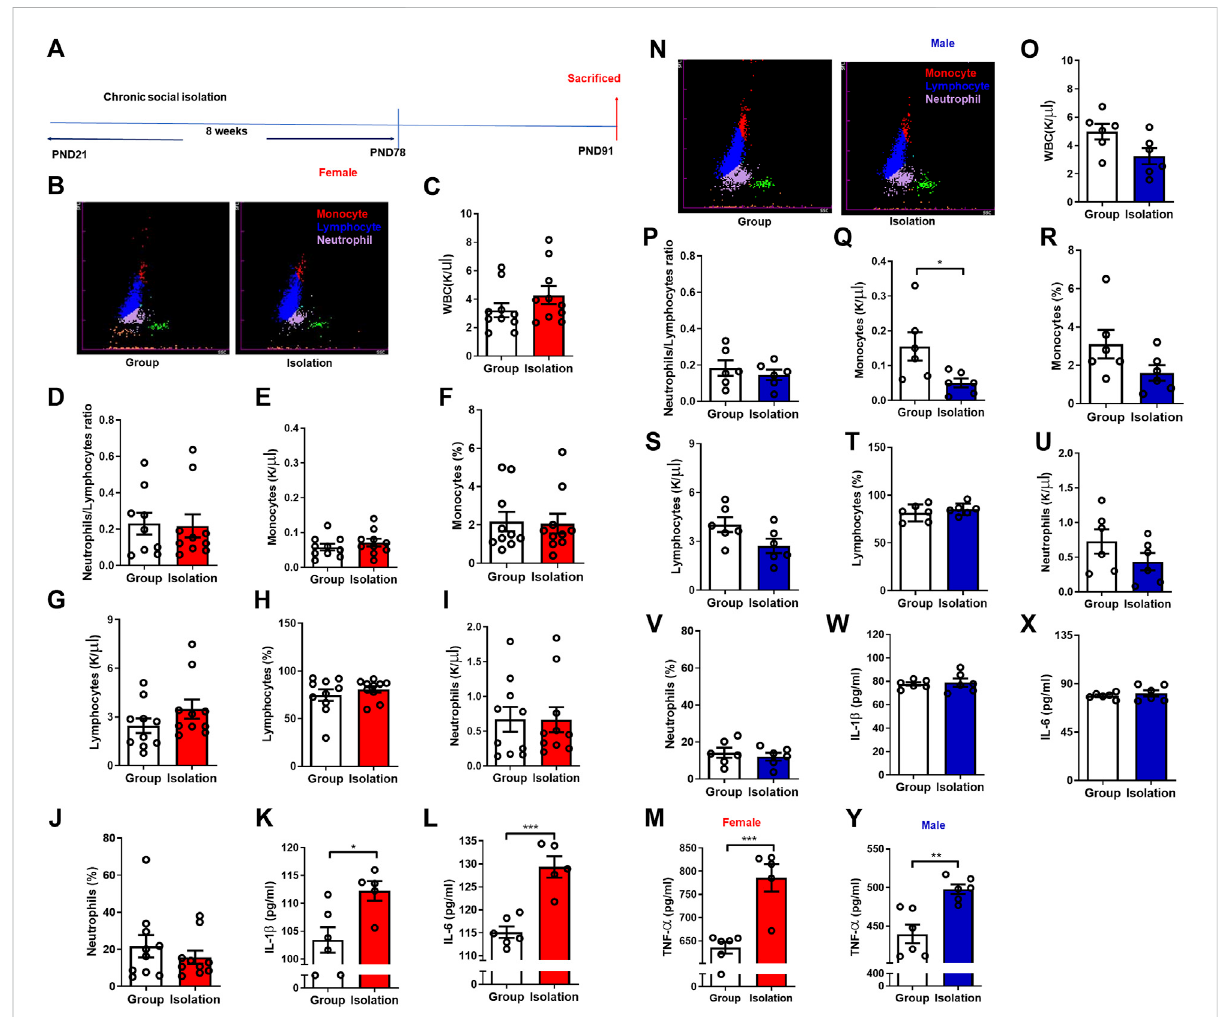
FIGURE 2 Childhood social isolation elevated peripheral in fl ammation in female mice. (A) Timeline of the experimental procedure. (B) Representative images of fi ve-classi fi cation blood cell counts of female mice, and various WBC groups were represented by different colors: monocytes (red), lymphocytes (blue) and neutrophils (purple). (C) The total counts of WBC in female mice (red bars, n = 10). (D) The neutrophil/lymphocyte ratio. (E) The monocytes counts. (F) The monocytes percentage. (G) The lymphocytes counts. (H) The lymphocyte percentage. (I) The neutrophils counts. (J) Theneutrophilspercentage. (K) ThelevelsofIL-1 β , (L) IL-6, (M) TNF- α . (N) Representativeimagesof fi veclassi fi cationbloodcellcountsof male mice. (O) The total counts of WBC in male mice (blue bars, n = 6). (P) The neutrophil/lymphocyte ratio. (Q) The monocytes counts. (R) The monocytes percentage. (S) The lymphocytes counts. (T) The lymphocytes percentage. (U) The neutrophils counts. (V) The neutrophils percentage. (W) The levels of IL-1 β , (X) IL-6, (Y) TNF- α . Data were mean ± SEM, * p < 0.05, ** p < 0.01, *** p <